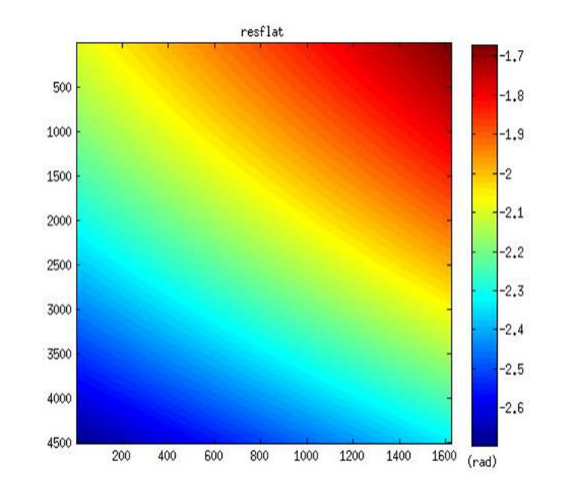
Figure 3. Phase induced by the baseline errors